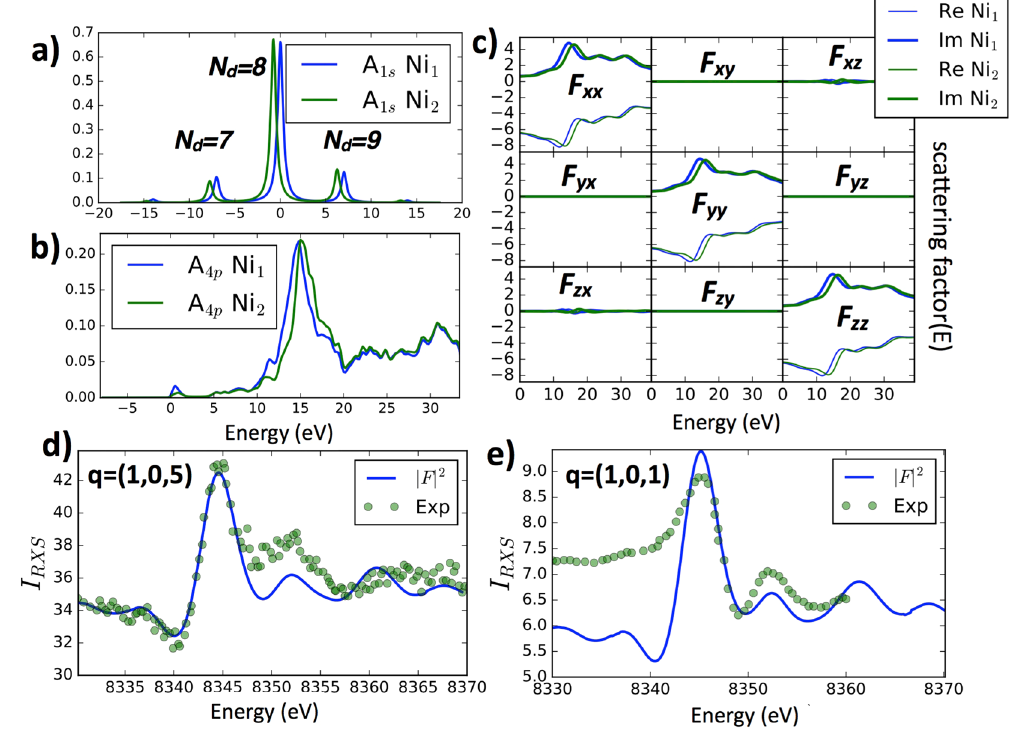
Figure 3. Resonant Elastic X-ray scattering on Ni K-edge. ( a ) The spectral function of the 1 s core state in the presence of the fluctuating valence of the Ni 3 d shell. ( b ) Ni 4 p density of state. ( c ) the energy dependent matrix of the scattering factor, where E means electron units ( d , e ) measured and computed X-ray scattering intensity at the two Bragg peaks. Experimental data in ( d ) are reproduced from ref. 13 and in ( e ) from ref.